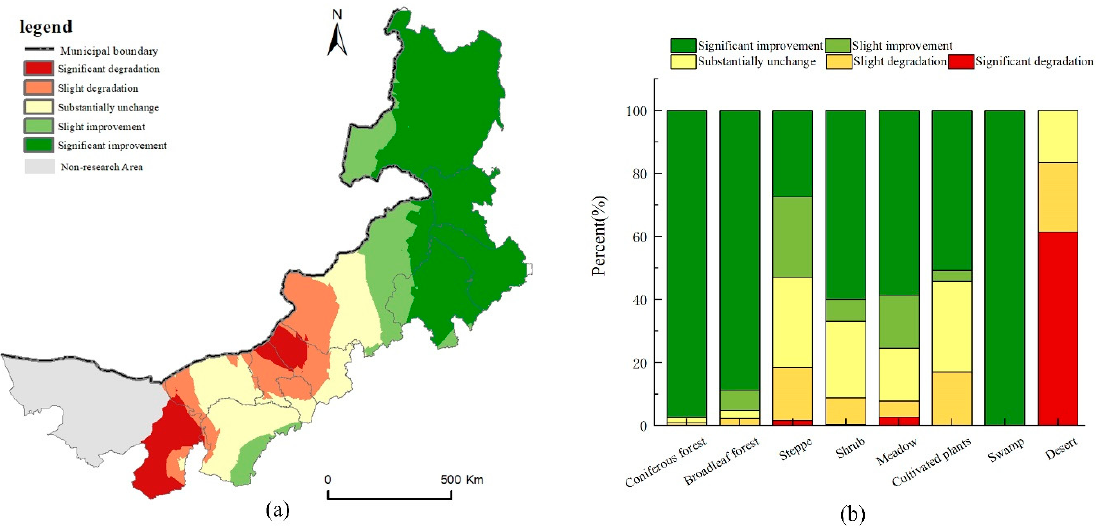
Figure 4. ( a ) The distribution of SPEI trend and ( b ) area percent in different land cover type.